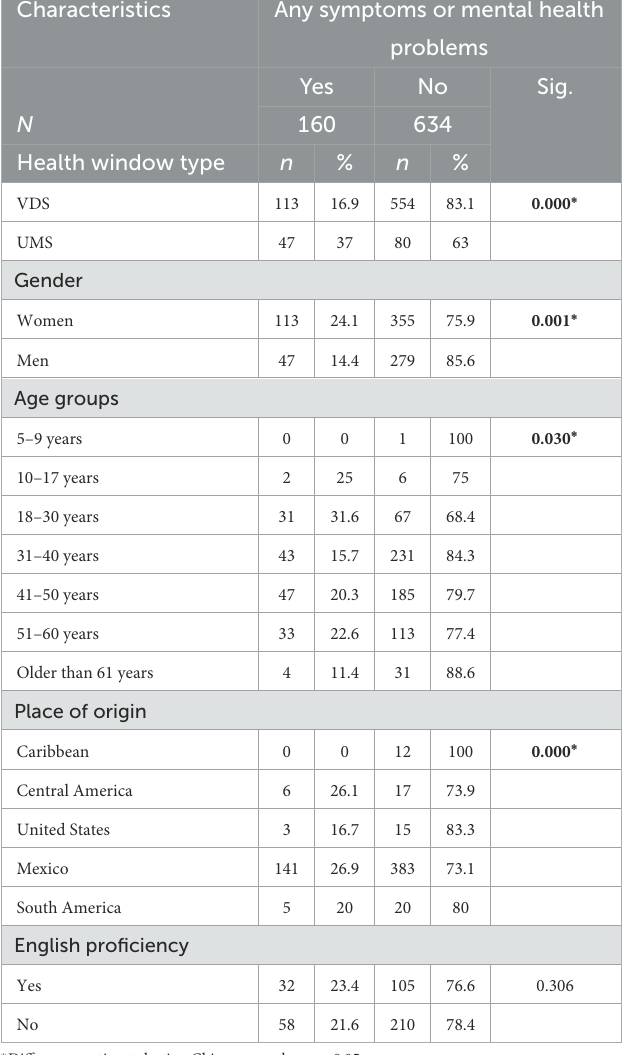
TABLE 1 Distribution of sociodemographic characteristics among the population with or without mental health symptoms/problems for screenings done at HW and MHU during